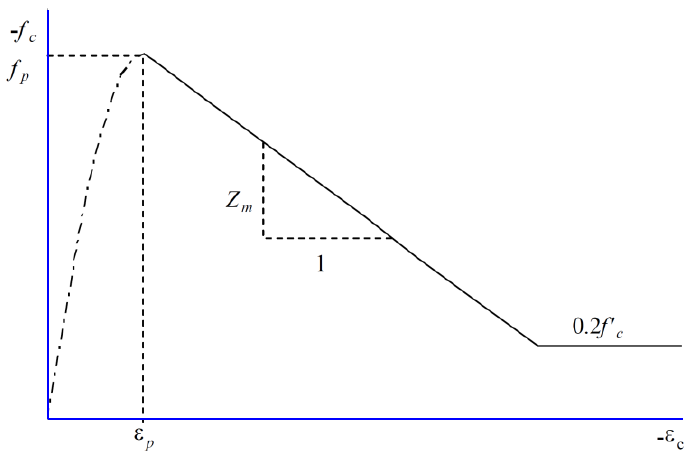
Figure 7. Modified Park – Kent model for post-peak concrete compression response.